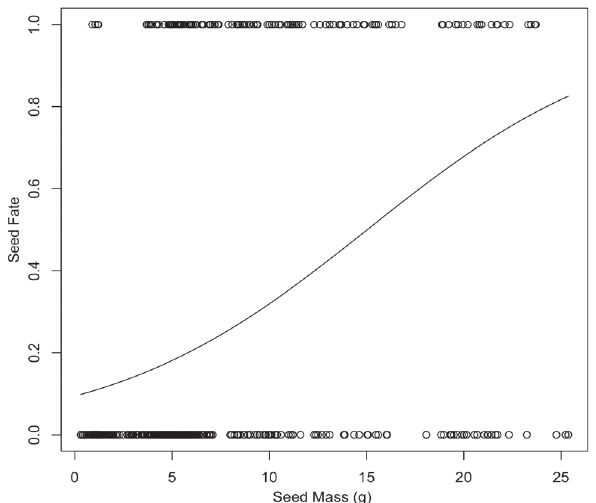
Figure 1. Logistic regression between seed mass and seed caching probability in six different tree species manipulated by red-rumped agoutis, D. leporina , at Anchieta Island, Atlantic forest,